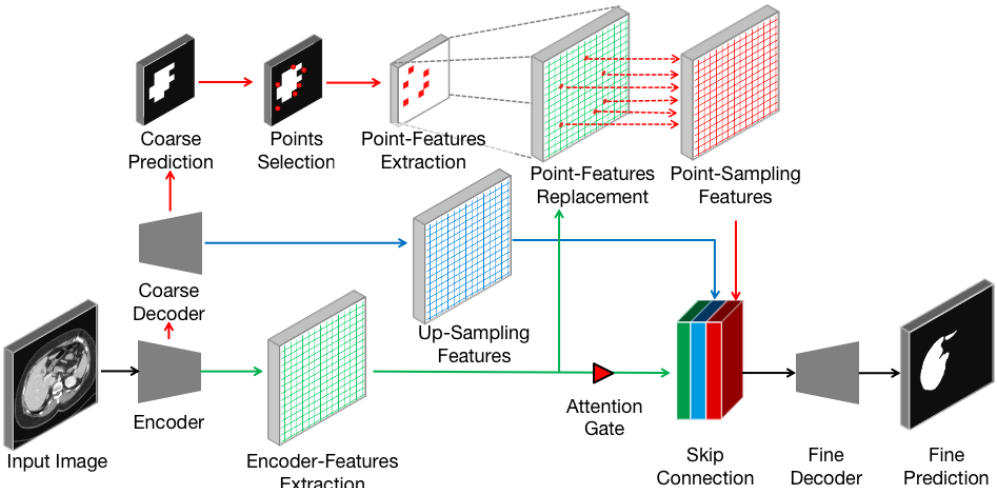
Figure 4. Detailed analysis of the Point-sampling method (red arrows, dots, and grids) applied to image semantic segmentation. A set of uncertain points from coarse prediction is selected to extract point-features. These features will replace original upsampling features and concatenate to refine the